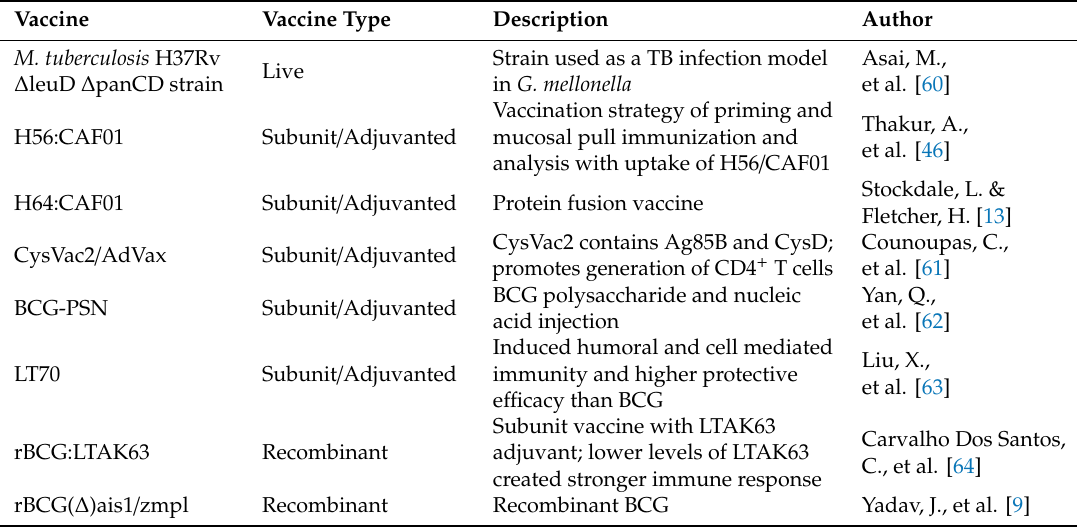
Table 3. Current vaccines in preclinical